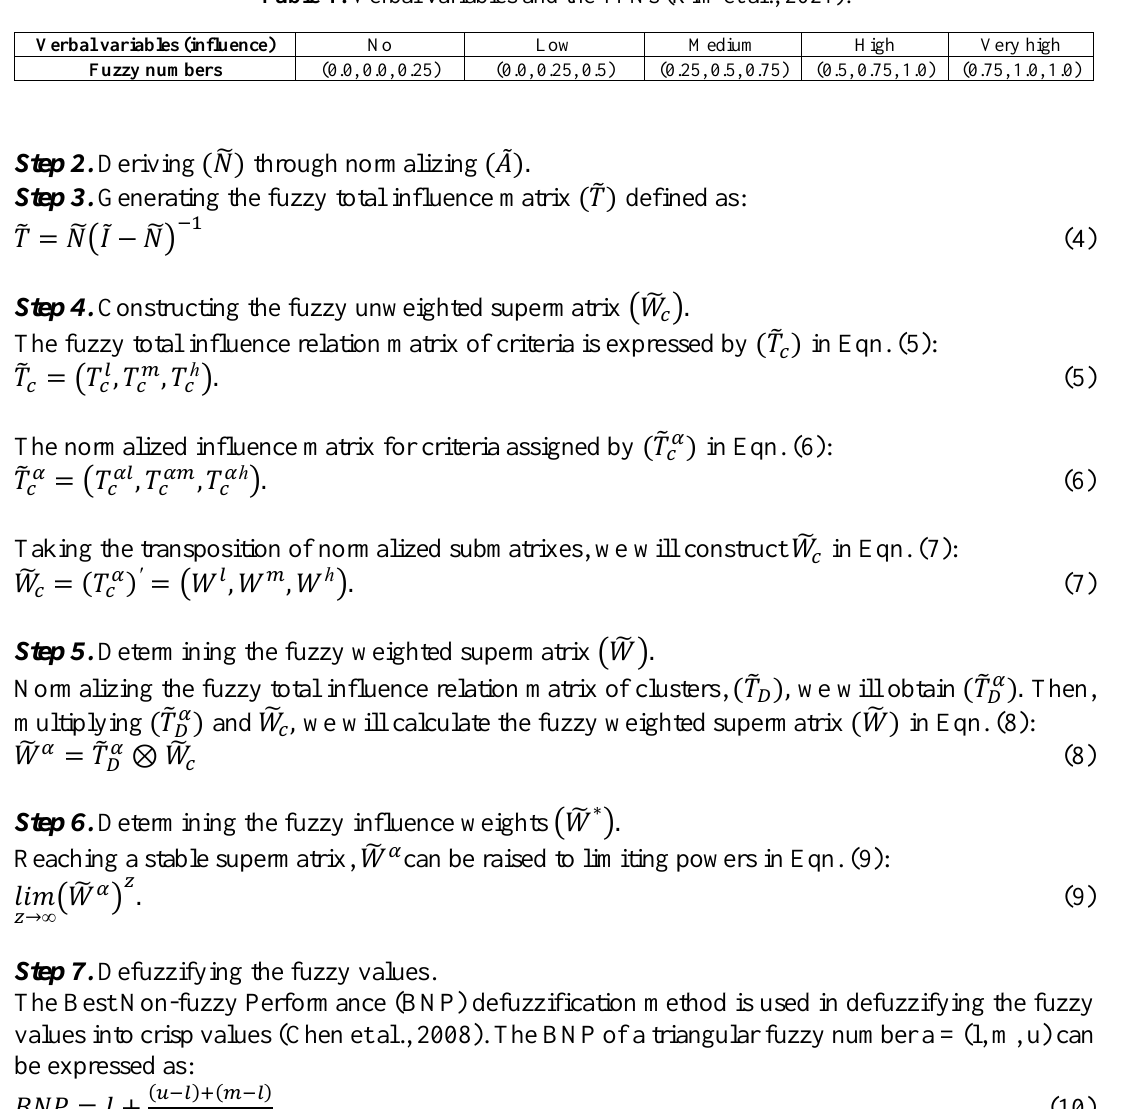
Table 1. Verbal variables and the TFNs (Kim et al.,